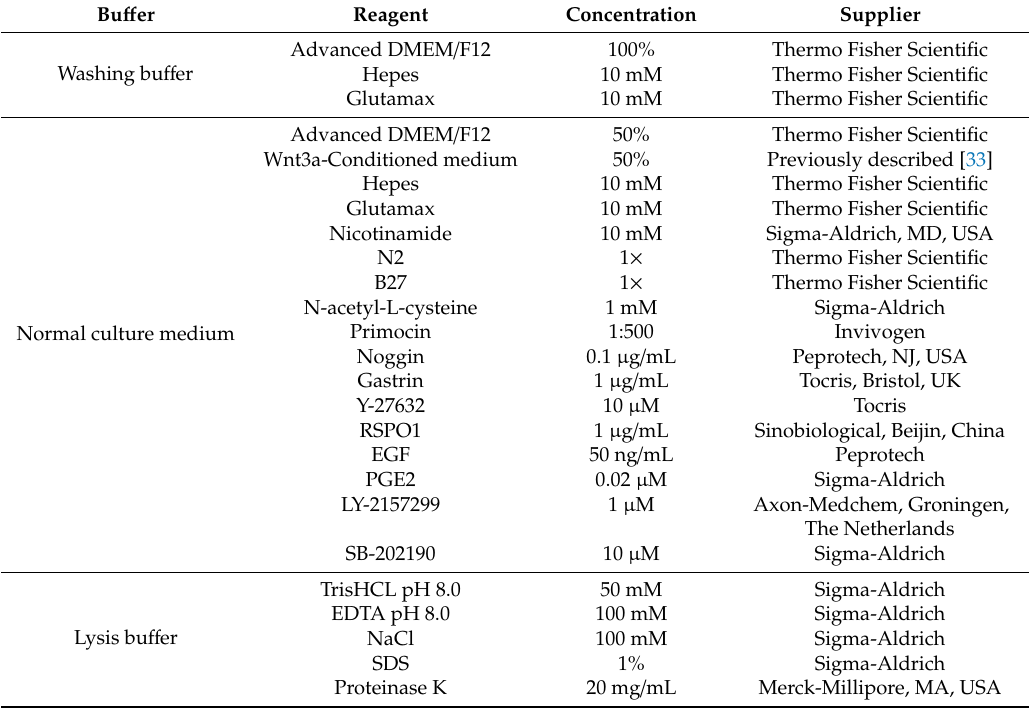
Table showing the reagents used in organoid